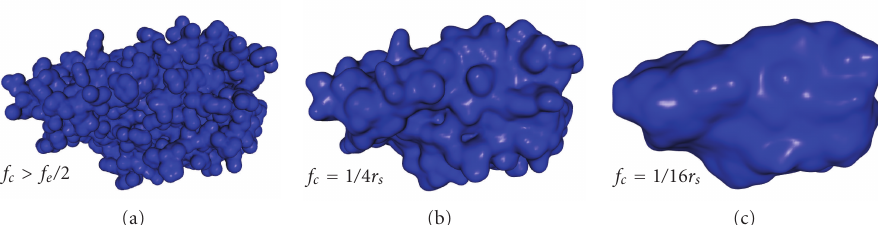
Figure 8: Meshes generated from electron density map filtered at a cuto ff frequency of f c > f e / 2 (a) to give the VdWS, f c = 1 / 4 r s (b) to give the SES, and f c = 1 / 16 r s (c) to give an approximation of the general shape. (PDB code: 3EBZ).